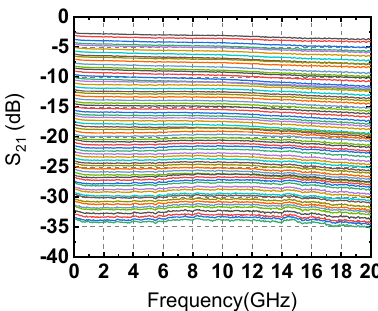
Figure 7. Measurement results of the S21 in all states.